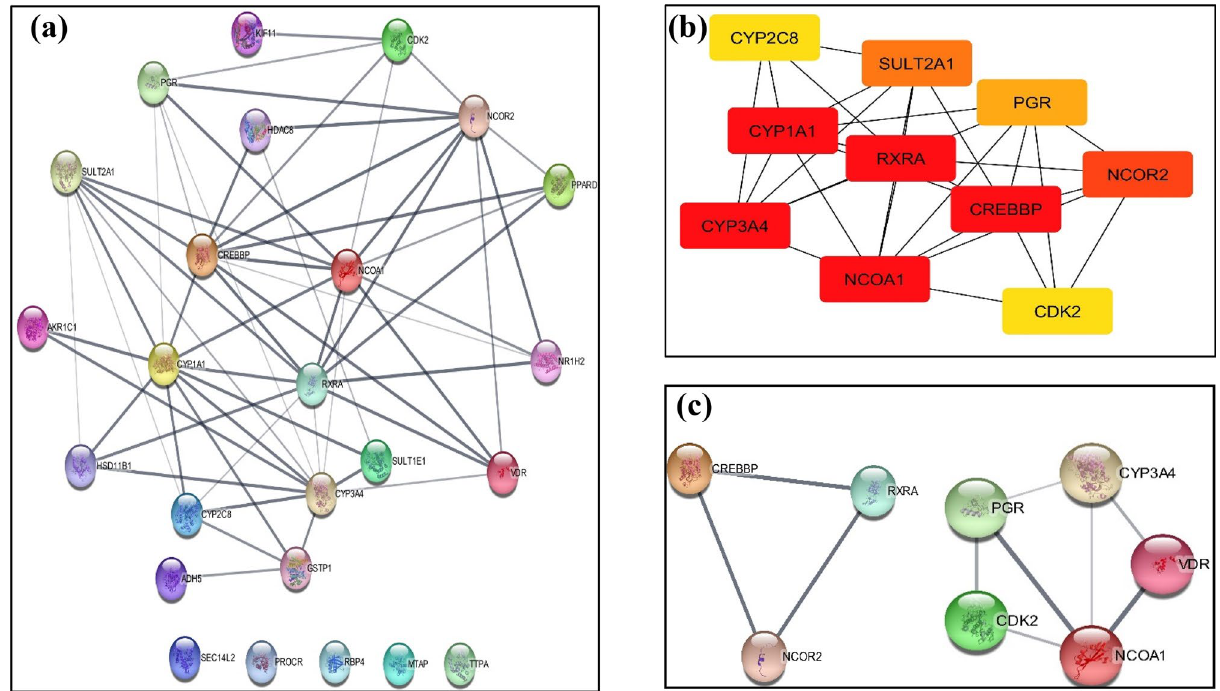
Figure 6. ( a ) PPI network constructed with STRING (The bold line represents direct interaction while the thin line represents indirect interaction), ( b ) Network of hub genes, and ( c ) two modules predicted by cytoHubba and MCODE plugins of